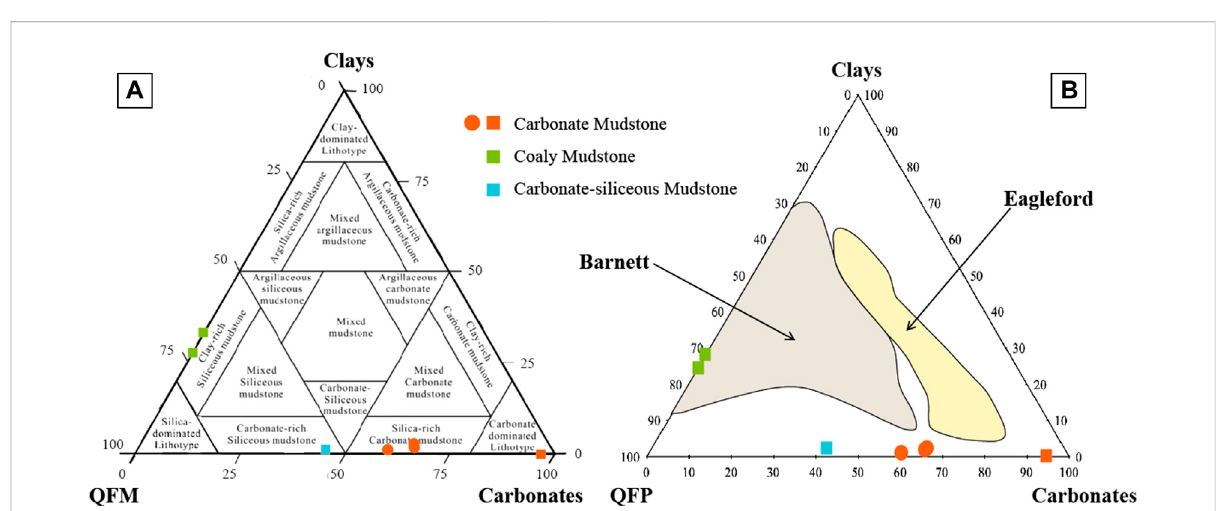
FIGURE 5 (A) Lithotype classi fi cation based on the ternary diagram of mineralogical composition from samples in the Huai Hin Lat Formation (modi fi ed afterGlaseretal.,2014). (B) MineralternaryplotcomparingtheHuaiHinLatmudstoneswithAmericananalogues (modi fi edafterBrindleetal.,2015). Most samples lie outside either formation but the coaly mudstones are more comparable with the Barnett formation than the Eagle Ford. The red rectangle, green rectangle, and blue rectangle represent the samples from location A, while the red dot denotes the samples from location B. Note that QFM refers to quartz, feldspar, and mica and QFP refers to quartz, feldspar, and